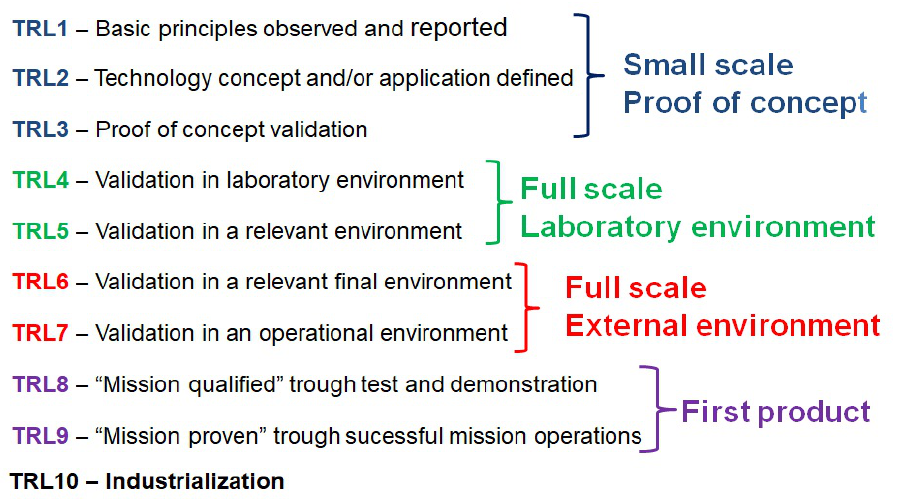
Figure 9. The stages of the MagLev 2 -Cobra project within the TRL scale.